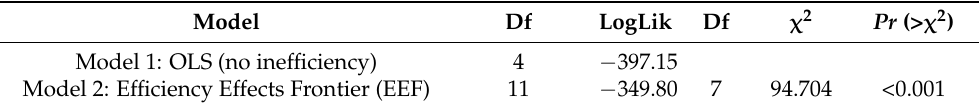
Table 7. Likelihood Ratio Test of the SFA Model with the Degrees of Freedom (Df), Log Likelihood Values (LogLik) and Test Statistics for the Assumed χ 2 -Distribution